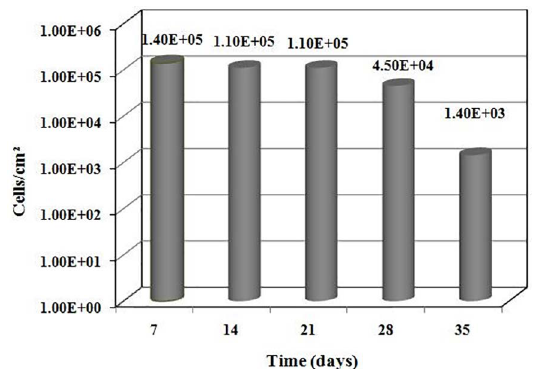
Figure 1. Quantification of sessile SRB cells by the most probable number (MPN)